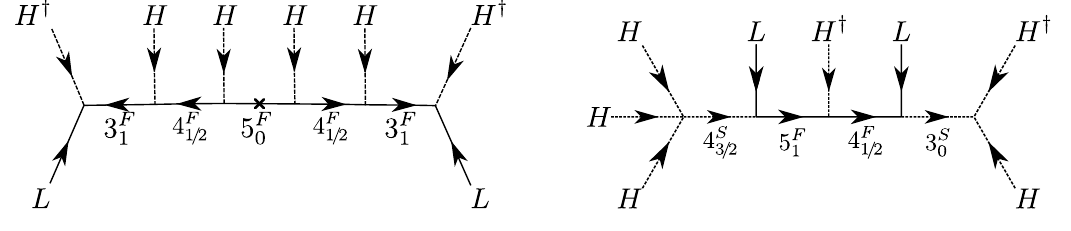
Figure 7 . The two genuine diagrams at d =